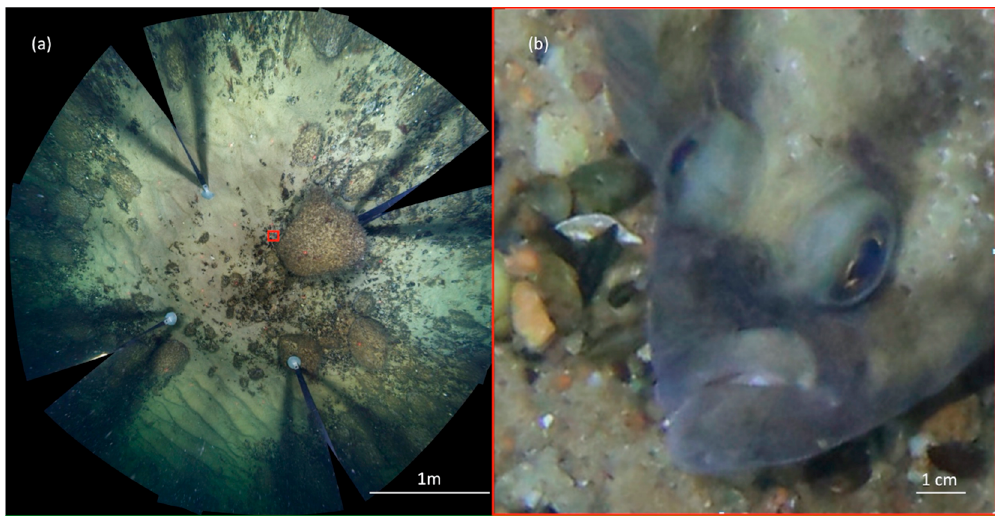
Figure 3. Example of a typical mixed hard and soft seafloor habitat on Hoburgs Bank. ( a ) Full drop-camera photomosaic covering 15m 2 seafloor. ( b ) Detail zoom showing a flatfish, mussels and substrate.